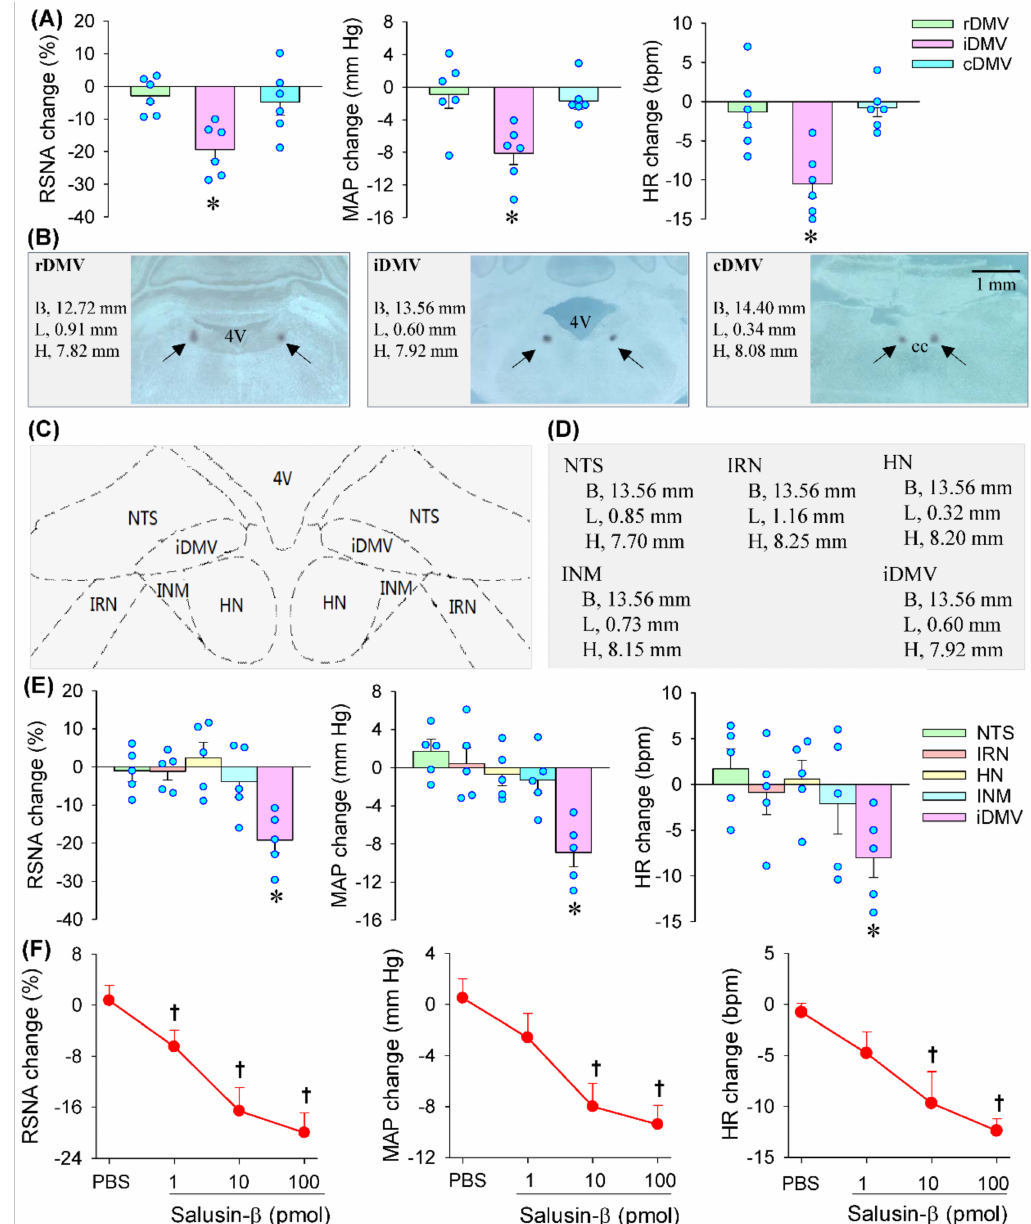
Figure 1. Effects of microinjection of salusin- β in dorsal motor nucleus of the vagus (DMV) on RSNA, MAP and HR. ( A ) Effects of salusin- β (100 pmol) in different zones of DMV including rostral DMV (rDMV), intermediate DMV (iDMV) and caudal DMV (cDMV). ( B ) Representative images of DMV showing microinjection sites at rDMV, iDMV and cDMV. ( C ) Schematic diagram showing the nuclei around the iDMV such as nucleus tractus solitaries (NTS), intermediate reticular nucleus (IRN), hypoglossal nucleus (HN) and intermedius nucleus of medulla (INM). ( D ) The coordinates used for microinjection of salusin- β into the NTS, IRN, HN, INM and iDMV. ( E ) Effects of microinjection of salusin- β (100 pmol) into the NTS, IRN, HN, INM and iDMV. ( F ) Effects of different doses of salusin- β (1, 10, 100 pmol) in the intermediate zone of DMV (iDMV).* p < 0.05 vs. the value before microinjection. † p < 0.05 vs. PBS. 4V, the fourth ventricle; CC, central